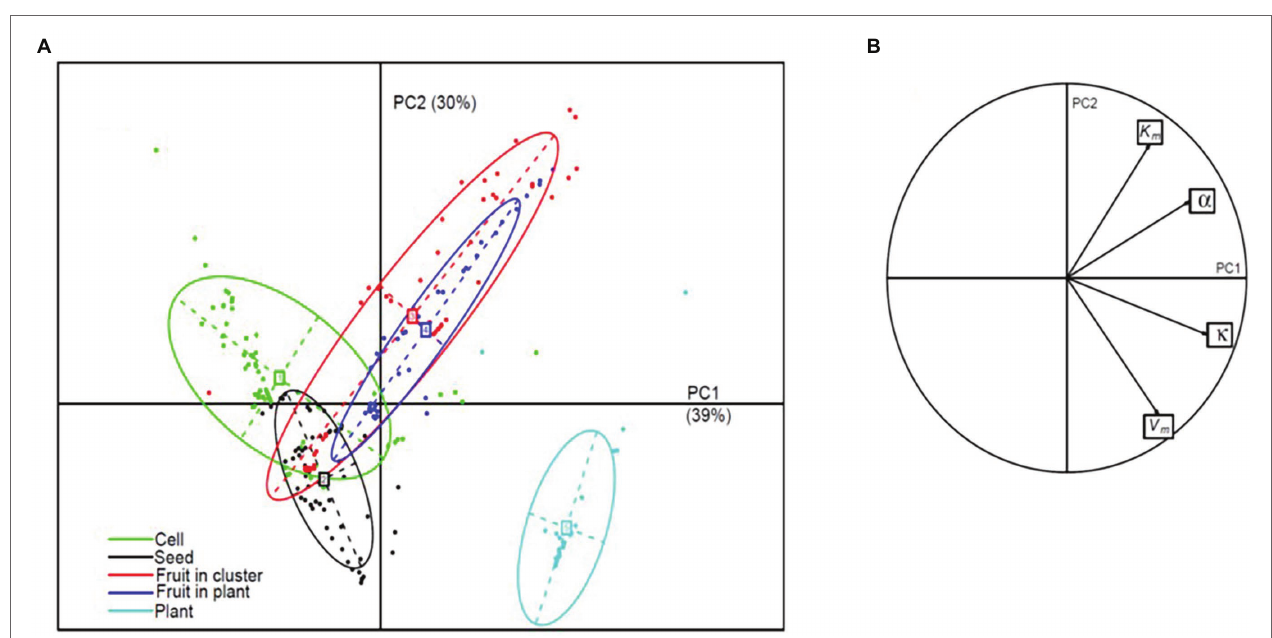
FIGURE 9 | PCA on phloem flow and sugar unloading parameters. (A) Projection, in the plane of the first two principal components, of the 243 sets of parameters grouped by organisation level, represented as inertia ellipses (encompassing about 75% of the points); the percentage of the variance explained by each component is indicated in brackets. (B) Parameter co-ordinates normed to the square root of the eigenvalue on the correlation circle.